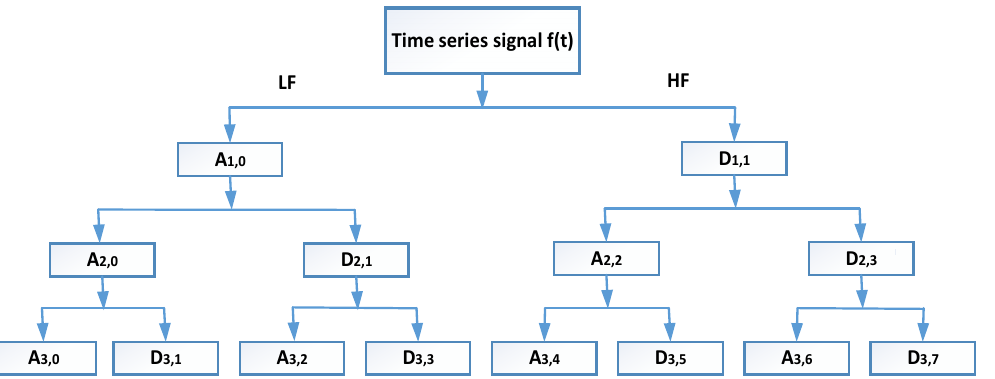
Figure 4. Wavelet Packet Transform decomposition tree (three levels). First, the time series signal 𝑓(𝑡) is passed through couple of low-pass filter (LF) and high-pass filter (HF) in order to divide 𝑓(𝑡) into low frequency and high frequency components known as approximation coefficient (A1,0) and detail coefficient (D1,1) respectively. The approximation coefficient (A1,0) and the detail coefficient (D1,1) will split themselves again into a second level approximation and detail coefficients and the process is repeated. WPT can be expressed as Equation (10).